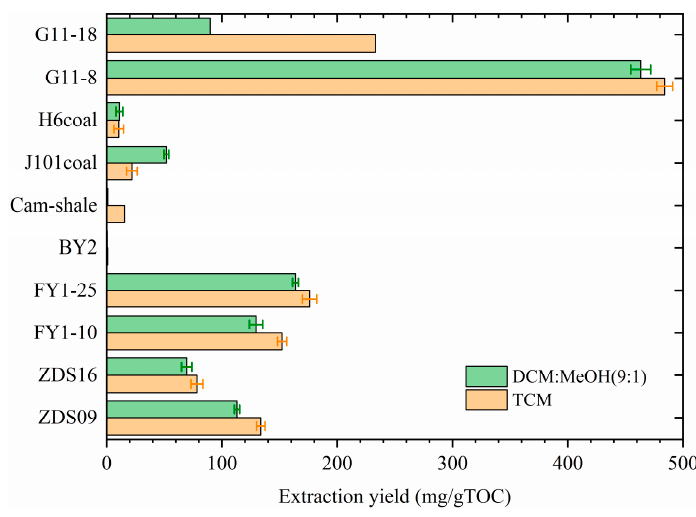
Figure 1. Extraction yields of samples using TCM and DCM: MeOH.